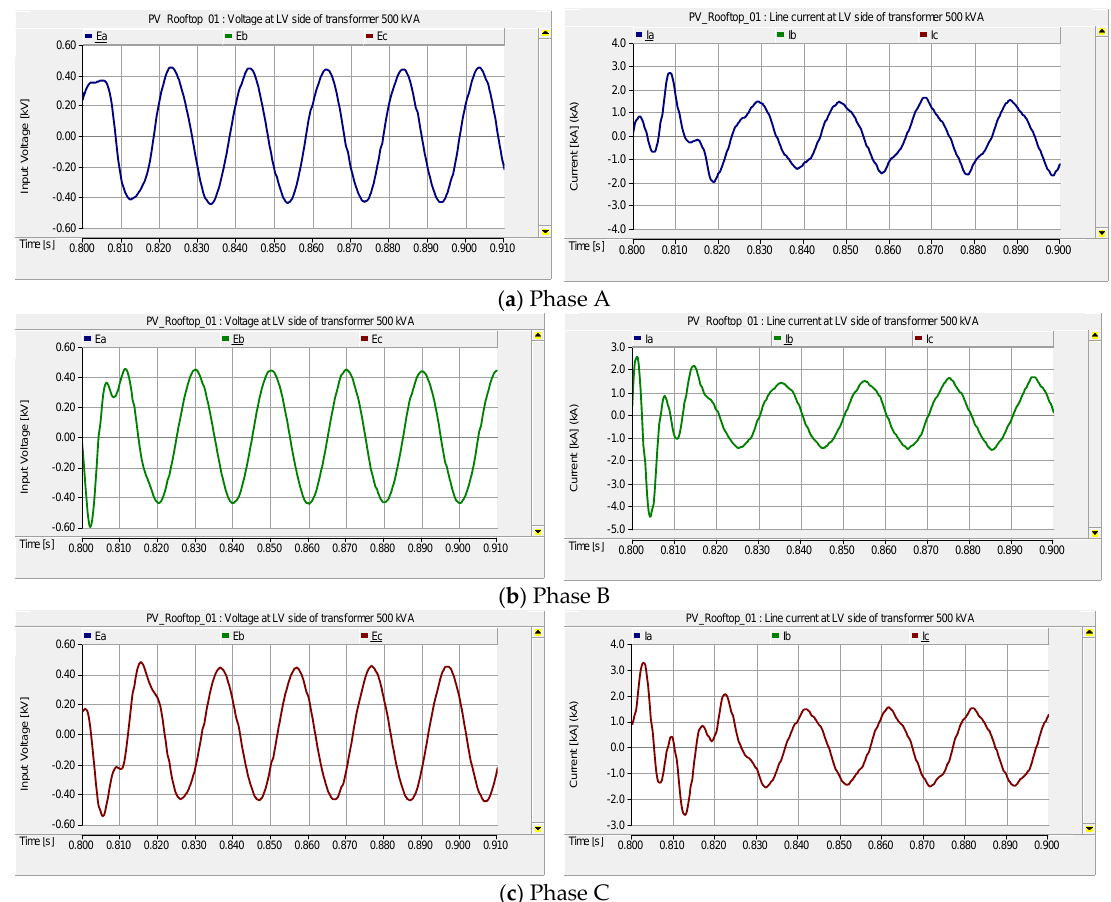
Figure 27. The voltage and current at the LV side (0.4 kV) transformer 500 kVA when the BRKB close circuit is at 0.8 s.